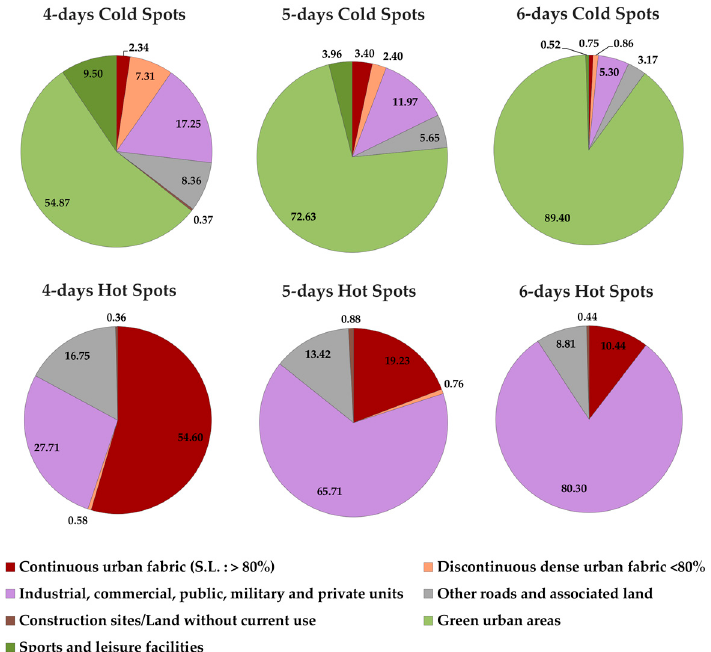
Figure 6. Land use percentages of the “hot spot” and “cold spot” categories.